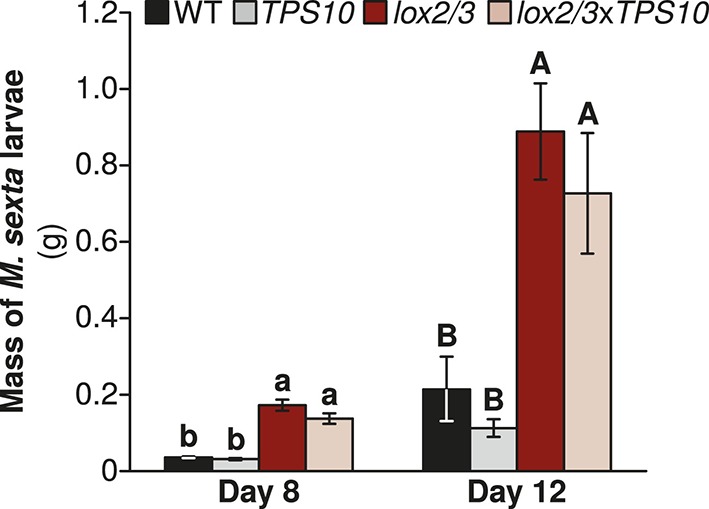
Manduca sexta larvae grow larger on LOX2/3-deficient plants, regardless of TPS10 expression, in a glasshouse experiment.Data are shown as mean ± SEM; n = 15–19 larvae on day 8 and 11–16 larvae on day 12. One M. sexta neonate per plant (starting n = 25 larvae) was placed immediately after hatching on the youngest rosette leaf of an elongated plant. Larvae were weighed at the third and fourth instars (of 5 total), corresponding to days 8 and 12, after which larvae become mobile between plants. a,b/A,B Different letters indicate significant differences (corrected p<0.001) in larval mass on different plant genotypes within each day, in Wilcoxon rank sum tests following significant (corrected p<0.001) Kruskal–Wallis tests for each day (WT vs lox2/3 day 8, W17,19 = 310, corrected p<0.001, day 12, W15,15 = 217, corrected p<0.001; TPS10 vs lox2/3xTPS10, day 8, W15,20 = 290, corrected p<0.001, day 12, W11,14 = 143, corrected p<0.001; WT vs TPS10 day 8, W17,15 = 95, corrected p=0.227, day 12, W15,11 = 56, corrected p=0.361; lox2/3 vs lox2/3xTPS10 day 8, W19,20 = 249, corrected p=0.201, day 12, W16,14 = 134, corrected p=0.377). p-values were corrected for multiple testing using the Holm-Bonferroni method.